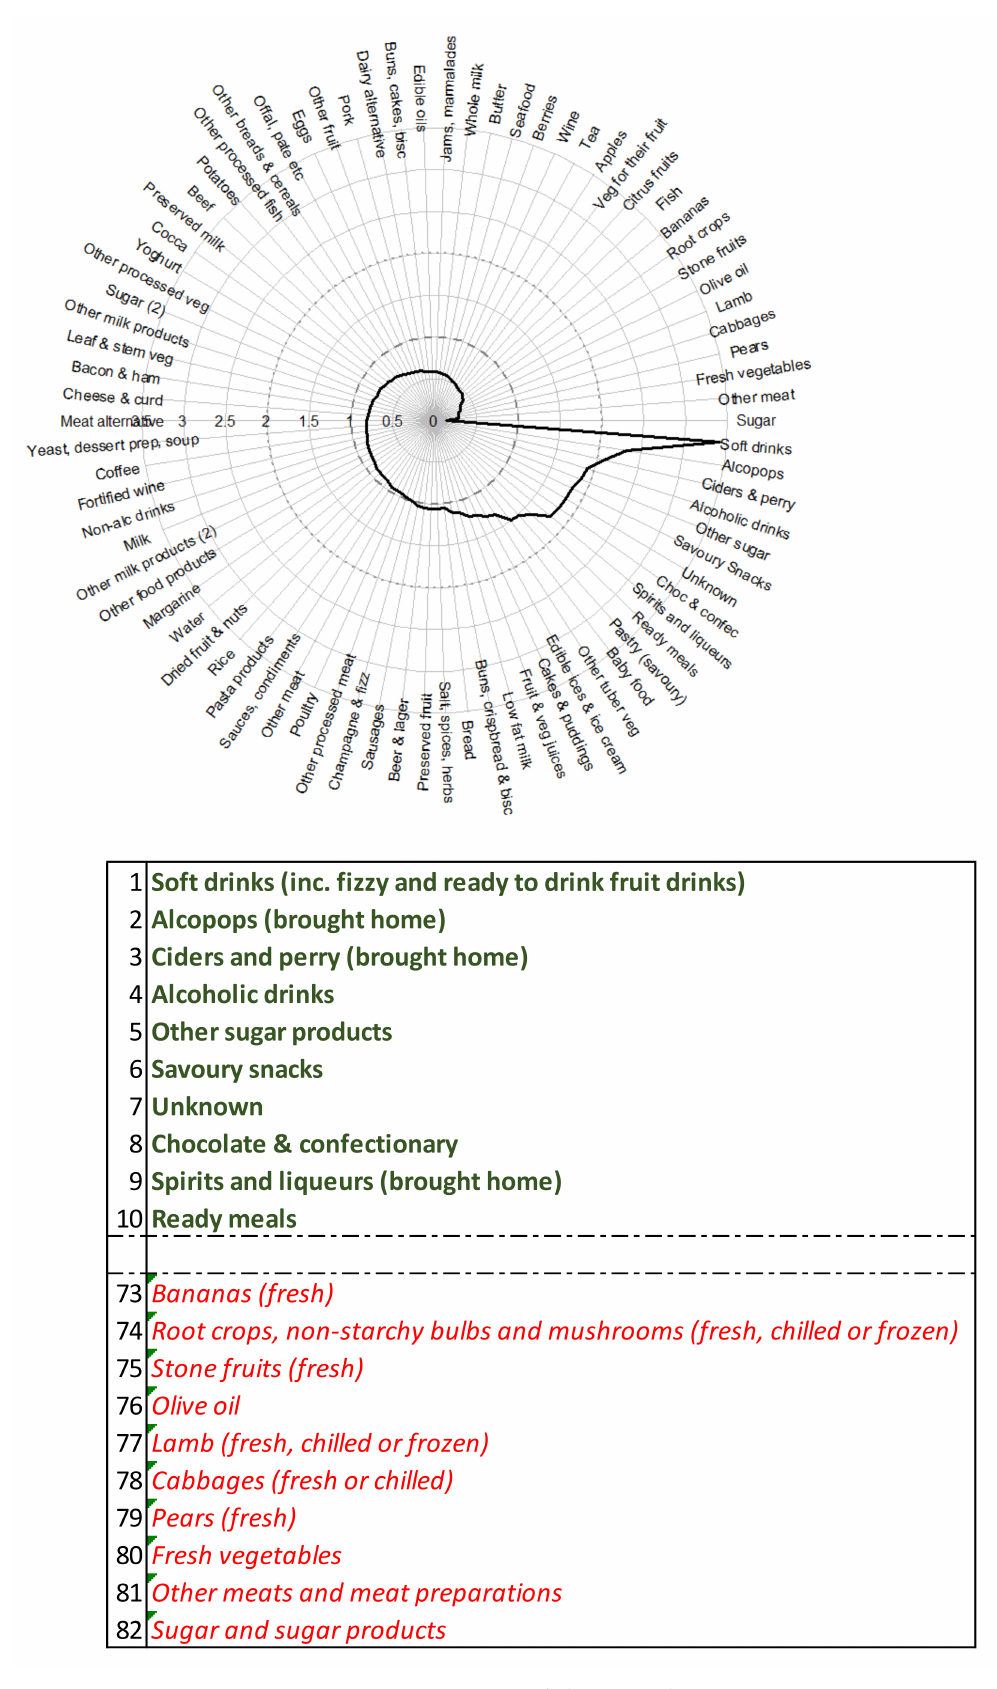
Figure A7. Sweet tooth ( n =